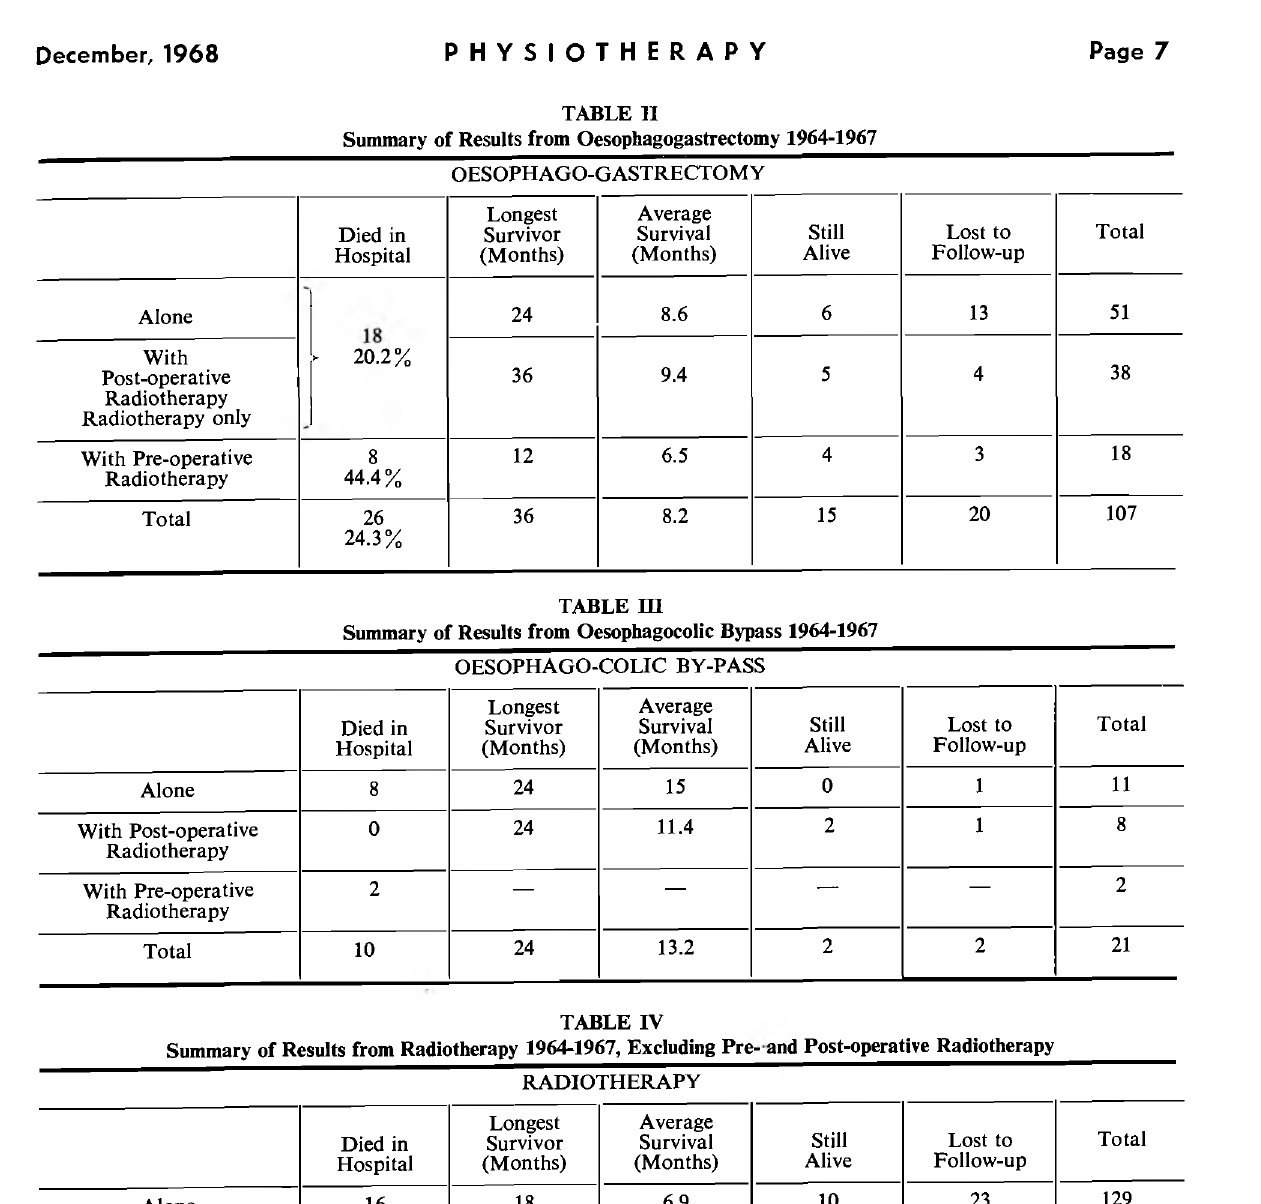
TABLE II Summary of Results from Oesophagogastrectomy 1964-1967_______________________________